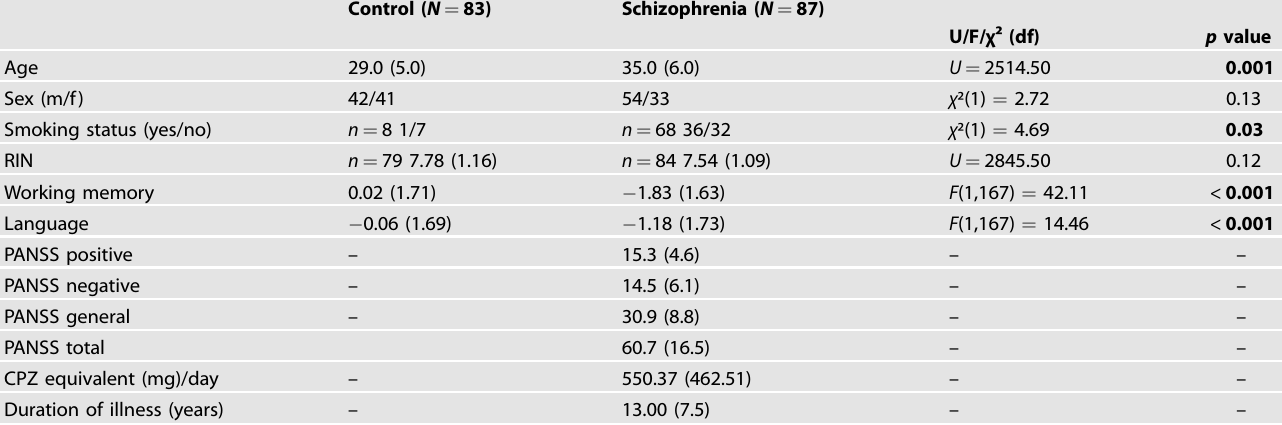
Table 1. Demographic and cognitive variables in control and patient